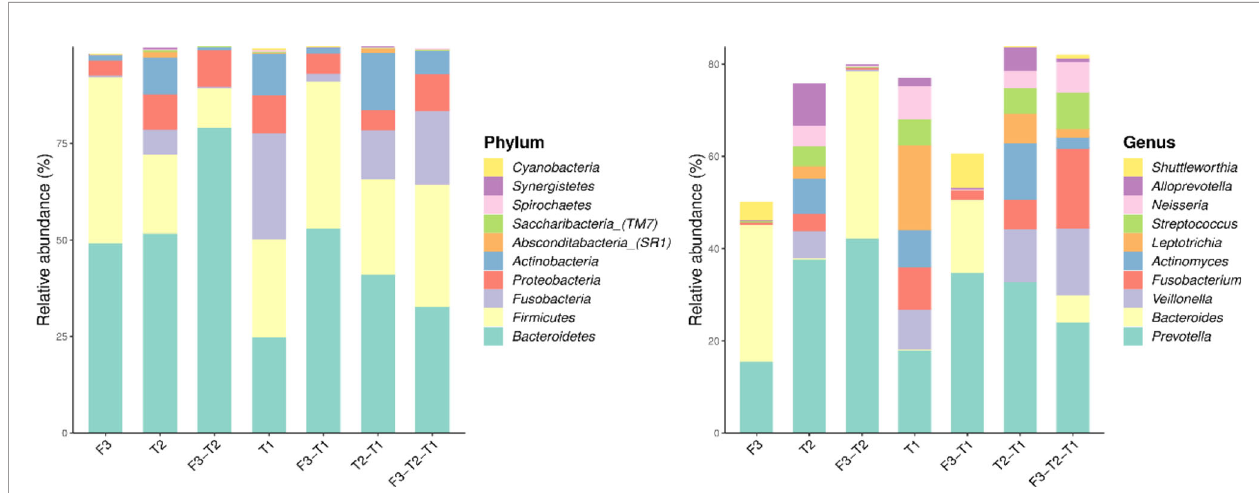
FIGURE 5 | The common and unique ASV composition of intestinal and tongue coating microbiota (only show the top 10 in abundance, the left is at the phylum level, the right is at the genus level).